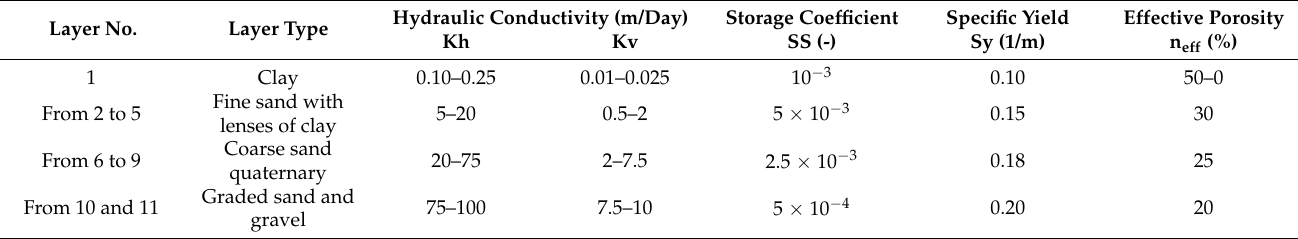
Table 2. Hydraulic parameters of the ENDA for each layer [36].